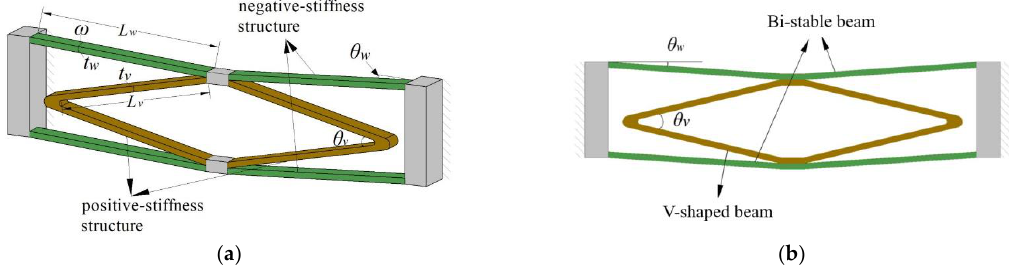
Figure 1. A schematic of the CFM: ( a ) axonometric view; ( b ) front view.